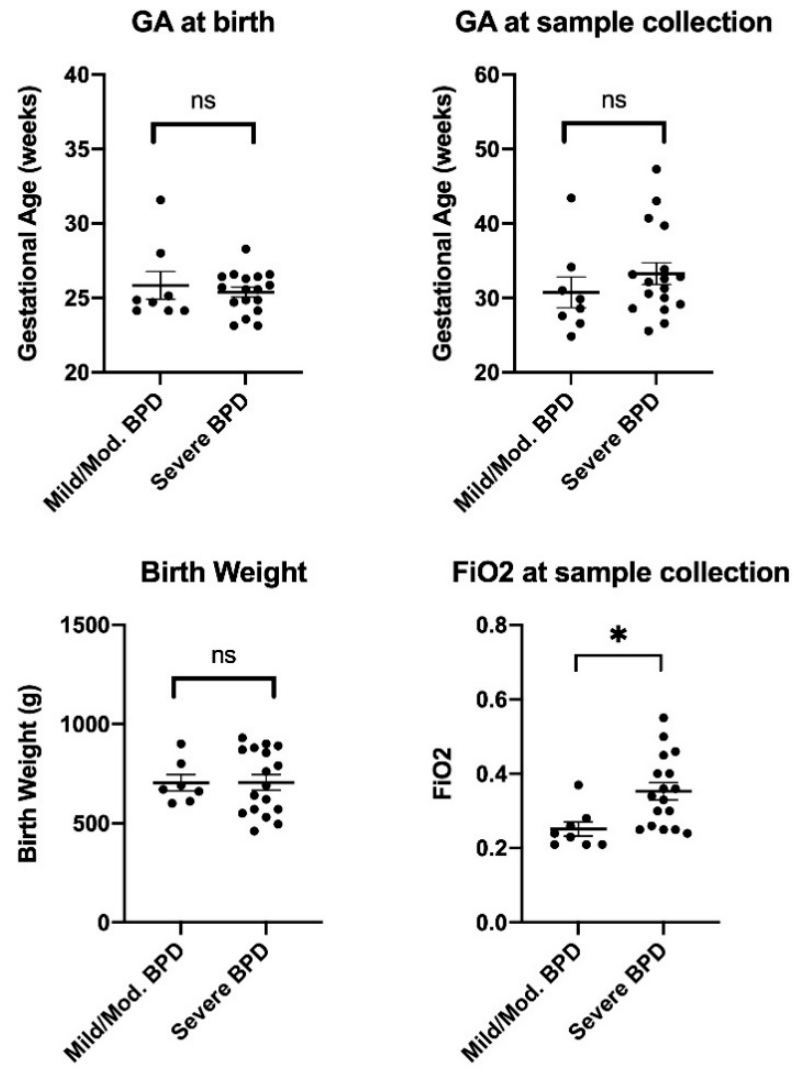
Figure 1. Patient demographics. Gestational age (GA) at birth and at sample collection time, birth weight, and fraction of inspired oxygen (FiO2) in mild/moderate (Mild/Mod.) and severe bronchopulmonary dysplasia (BPD) infants enrolled. No differences are observed between groups for GA or birth weight parameters. The FiO2 at sample collection time is significantly higher in the severe BPD group when compared to the Mild/Mod. BPD group (unpaired t -test, * p = 0.0104).